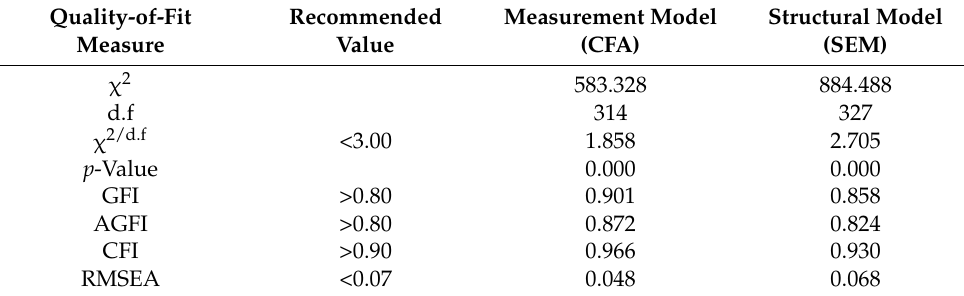
Table 4. Model fit indices and target values in CFA and SEM.